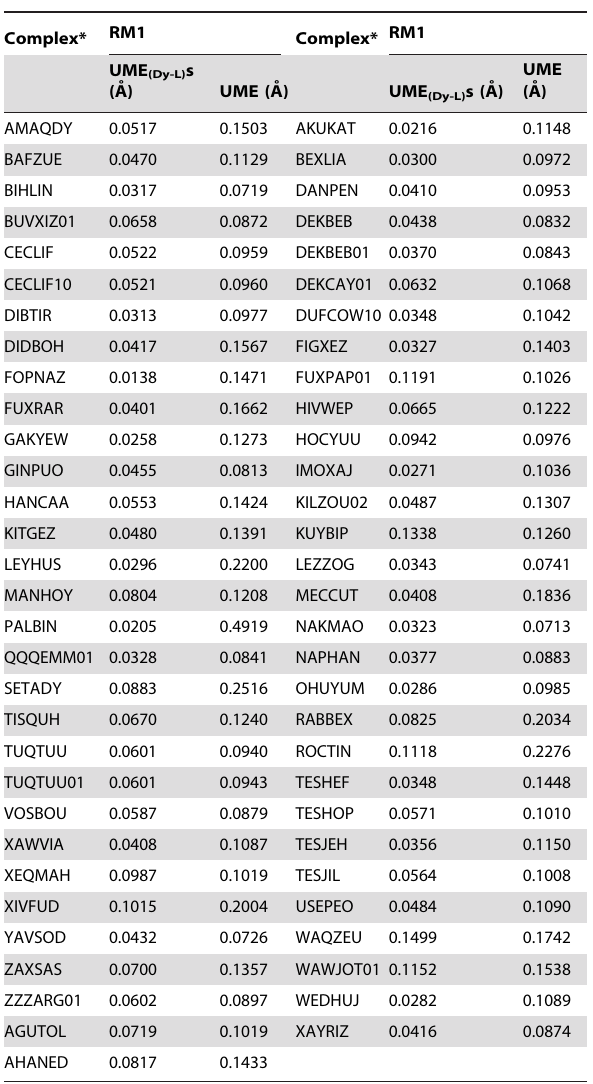
Table 2. Unsigned mean errors, UME (Dy-L) s and UMEs, for the RM1 model for the lanthanides, as compared to the respective experimental crystallographic values, obtained from the Cambridge Structural Database, [37–39] for each of the 61 dysprosium (III) complexes.